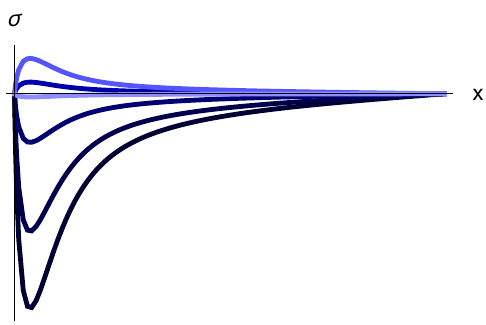
Figure 2. Evolution of the “classical” part of the non-stationary stress field, which corresponds to the roots R 1 , R 2 , and R 3 in the solution (33). The colormap goes from dark to light over time. The component of the solution, corresponding to the “classical” roots (Figure 2), attenuates rapidly over the time typical for the CTE model. At larger times, this component contributes insignificantly to the amplitude of the slower processes of mechanical waves absorption modeled with the filter function (20).